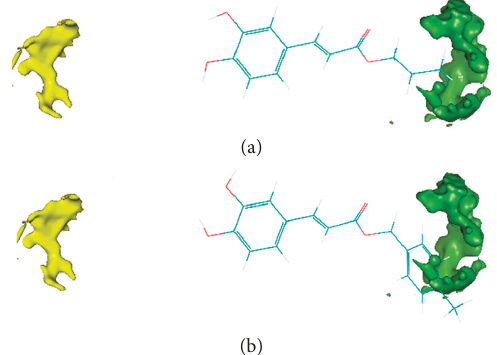
Figure 4: Steric contribution to Escherichia coli bioactivity for compounds 6 and 16 .